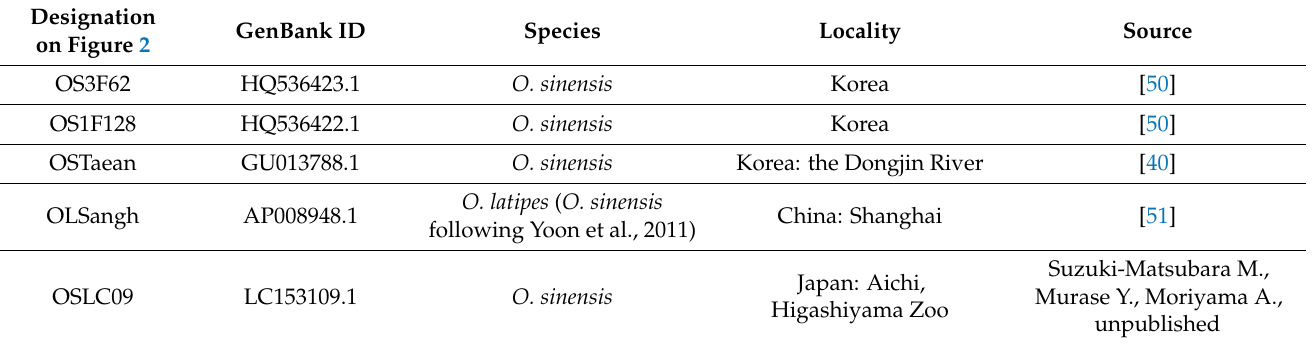
Table 2. Summary of the COI gene sequences for the Oryzias latipes and O. sinensis fishes available in the NCBI